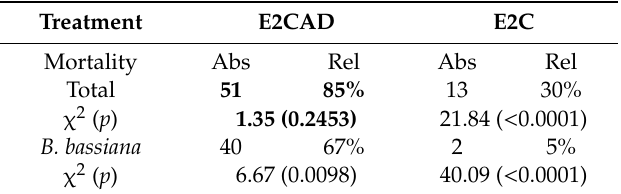
Table 5. Total and B. bassiana attributed absolute and relative mortality rates for treatments in experiment set two and corresponding results of the Chi-square tests. Values that are not significantly di ff erent from LD100 are highlighted in bold. Abbott’s formula was used to calculate relative mortality for thee treated group (E2CAD) due to mortality observed in the control group (E2C).